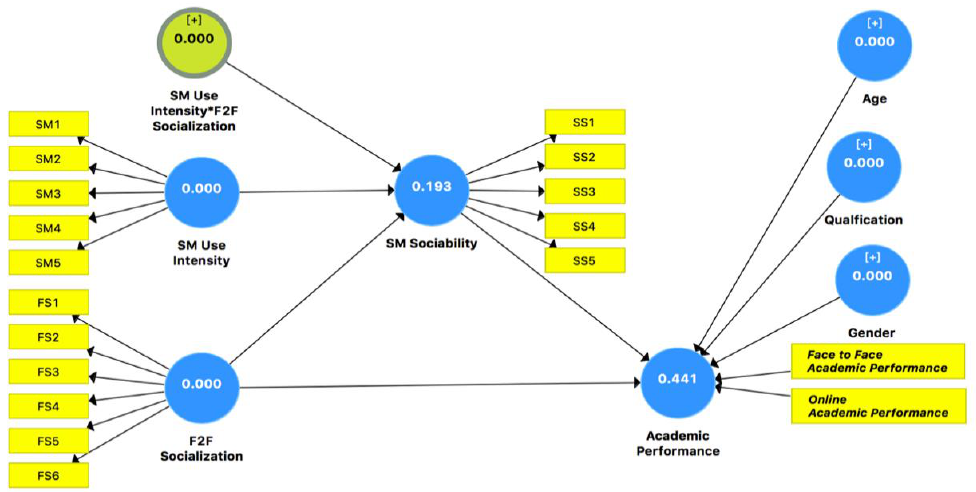
Figure 2. The redundancy analysis.